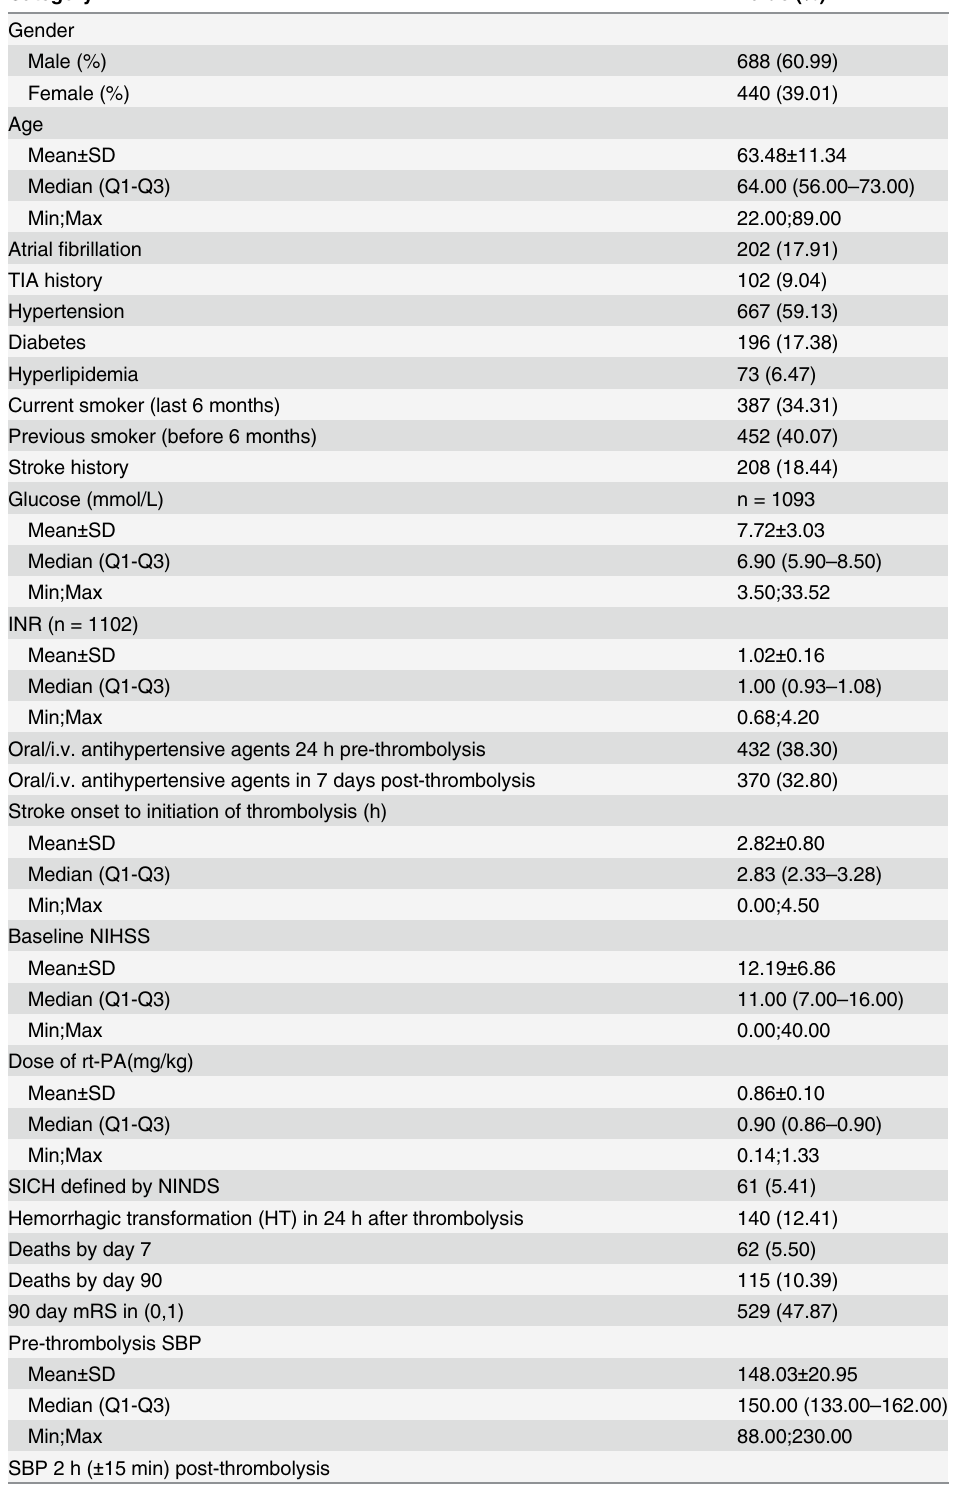
Table 1. Baseline characteristics and clinical